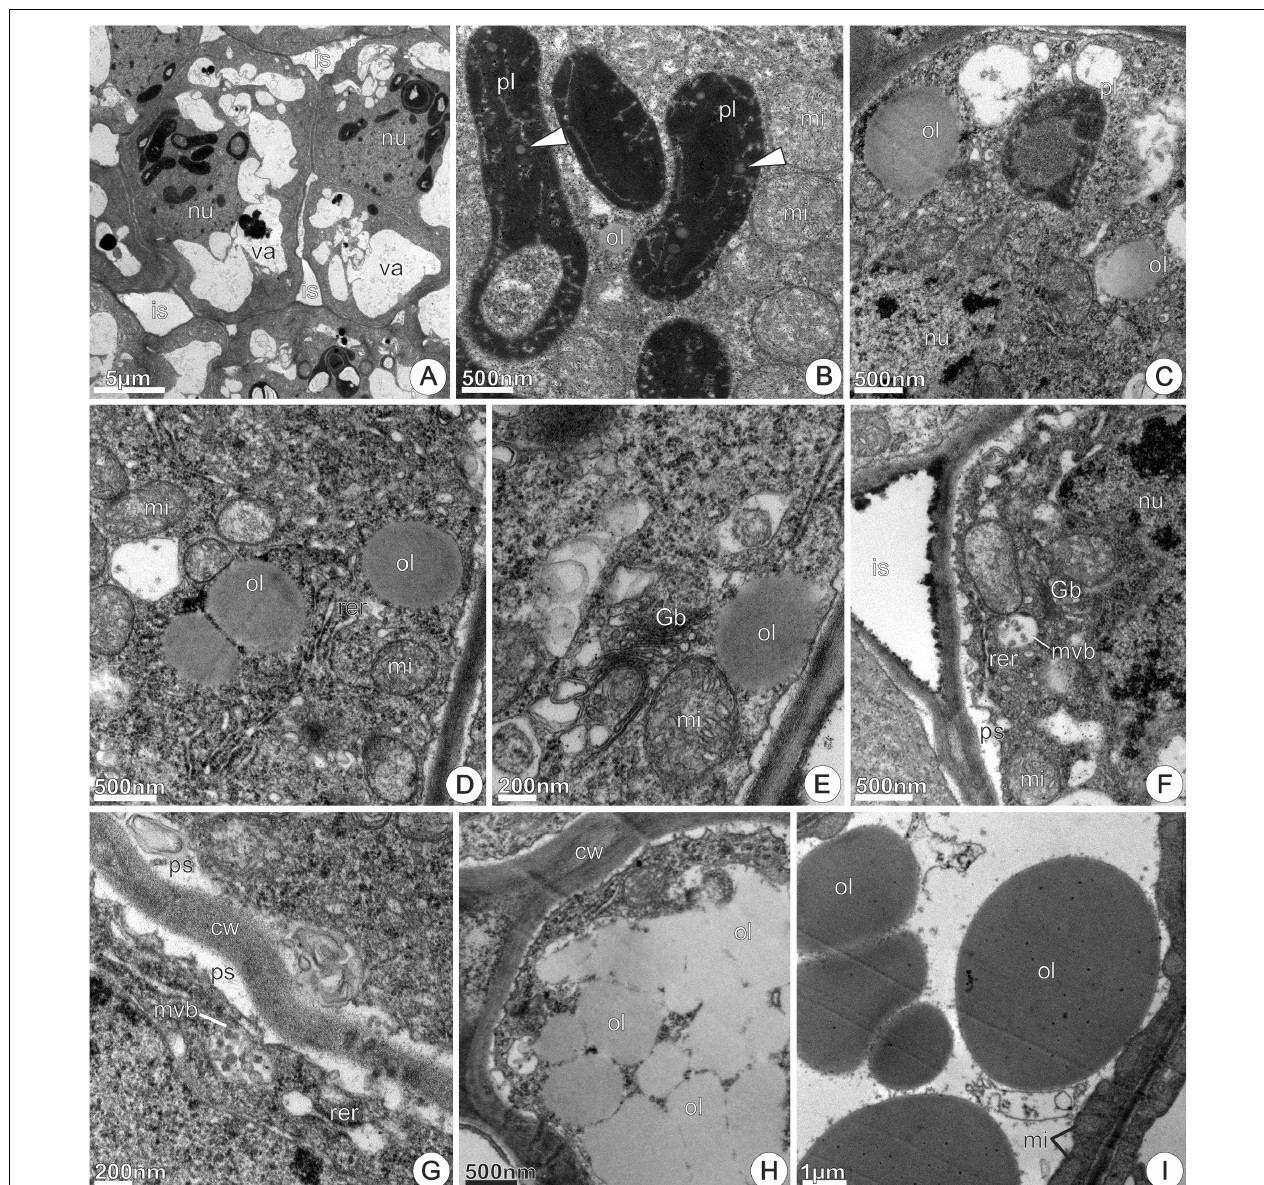
FIGURE 10 | TEM micrographs of the disk from Jacaranda oxyphylla nectariferous flowers, at 48 h of anthesis. (A) General view of the nectary parenchyma showing larger intercellular spaces and parenchyma cells with prominent nucleus and dense cytoplasm; (B) polymorphic plastids with electron-dense stroma, vesicular/tubular inner membranes and lipid globules; (C) large oil droplets, RER elements and mitochondria scattered through the cytosol; (D) part of a nectary parenchyma cell highlighting the conspicuous nucleus, modified plastid and oil droplets; (E) oil drop near the plasmalemma, numerous polyribosomes and hyperactive Golgi body; (F) mitochondria and RER elements positioned in the peripheral cytoplasm, sinuous plasmalemma and dense granulations inside intercellular space; (G) part of two nectary parenchyma cells highlighting multivesicular body in close juxtaposition with the plasmalemma that is sinuous, and developed periplasmic space containing dense granulations and multilamellar membranes; (H) assemblage of oil drops in the cytoplasm; (I) large oil bodies in the vacuole, and clustered mitochondria in the reduced parietal cytoplasm. cw, cell wall; Gb, Golgi body; is, intercellular space; mi, mitochondria; mvb, multivesicular body; nu, nucleus; ol, oil; pl, plastid; ps, periplasmic space; rer, rough endoplasmic reticulum; sg, starch grains; va, vacuole.